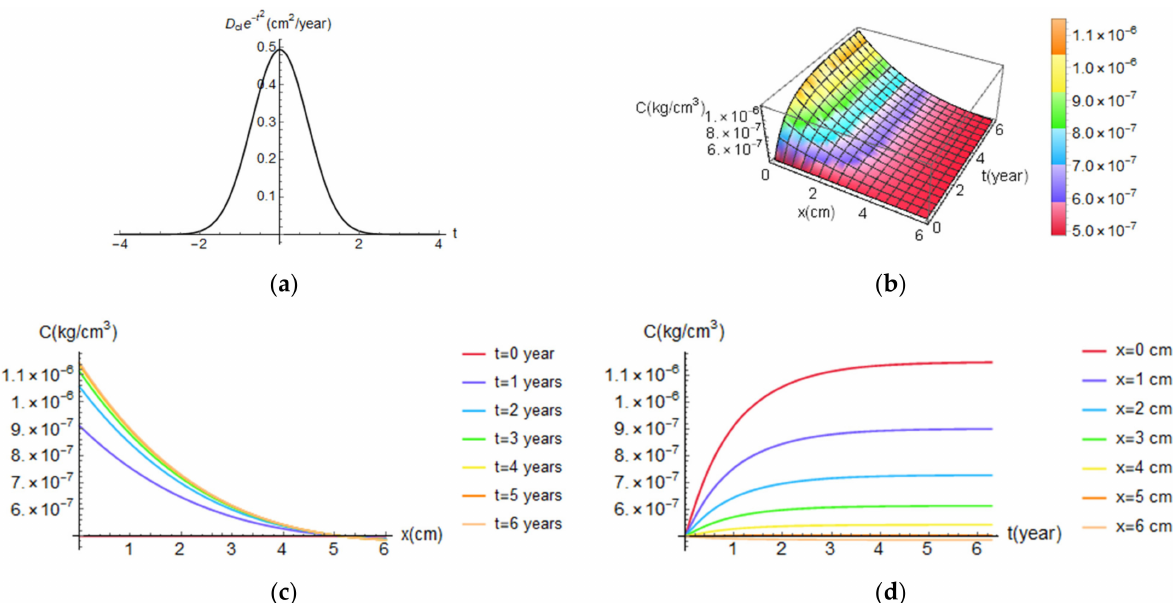
Figure 7. Numerical results for Gaussian f D (x,t): ( a ) its trend; ( b ) 2D complete results; ( c ) results in x domain; ( d ) results in t